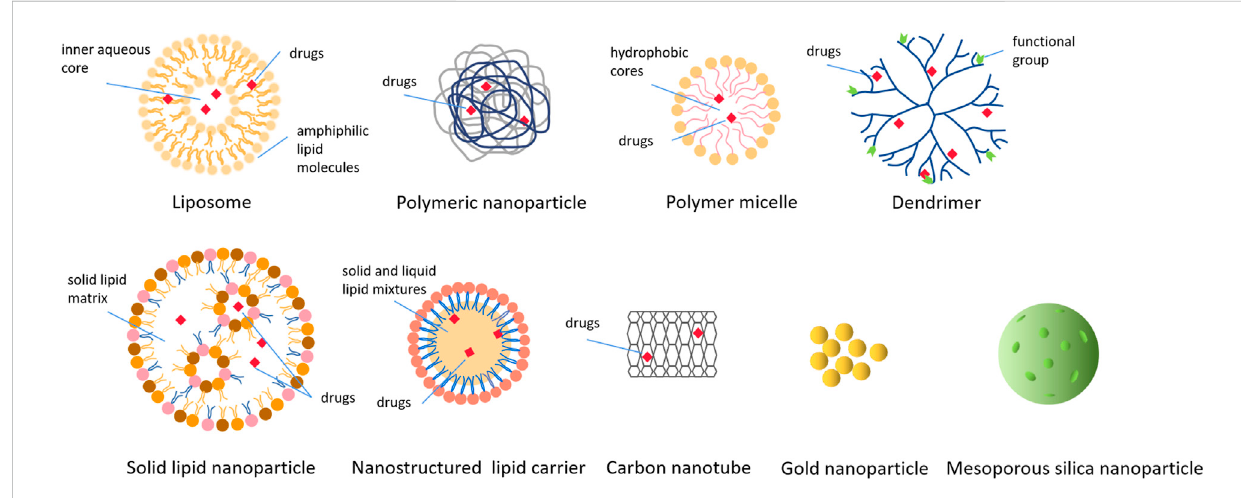
FIGURE 3 Various types of nanoparticles used to deliver drugs in cancer treatment. These nanoparticles include organic nanoparticles and inorganic nanoparticles, and this picture shows the structure and drugs loading of various nanoparticles in